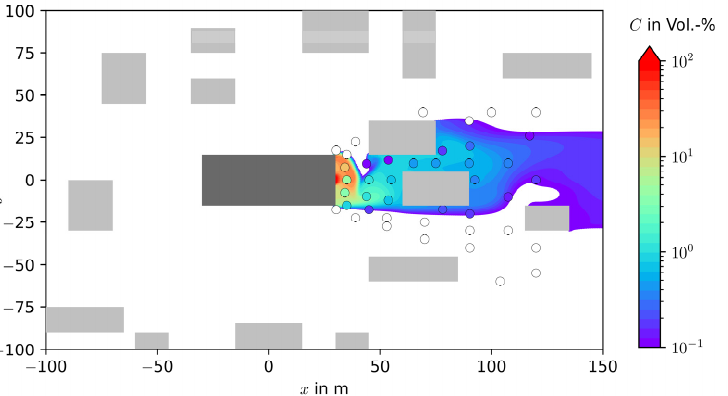
Figure 8. Isosurface of the gas concentration in 2 m height over ground for a neutrally buoyant gas release for case MR-M1-S3. Grey boxes representing buildings and the experimental measuring points represented by circles.